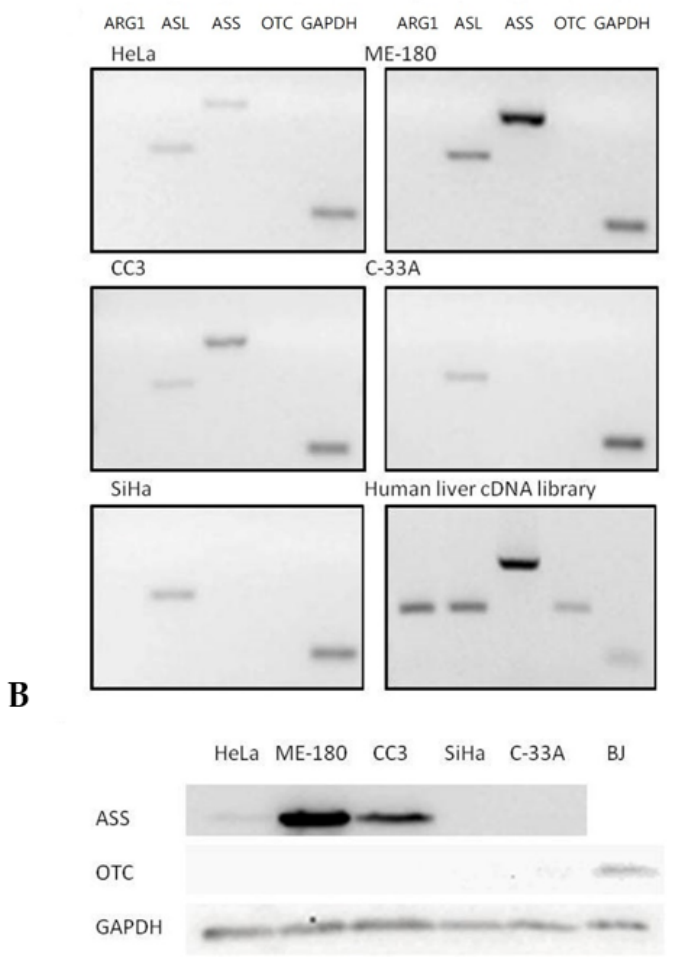
Figure 3. Expression profile of major urea cycle gene in human cervical cancer cells. ( A ) Transcriptional expression profiles in five human cervical cancer cell lines. The gene expression profiles of the cervical cancer cells and a positive control human liver cDNA library were determined using semi-quantitative RT-PCR and analyzed using agarose gel electrophoresis. ( B ) Protein expression of ASS and OTC was measured by Western blot analysis in five human cervical cancer cell lines. A positive control was performed using a normal human fibroblast cell line BJ. GAPDH served as internal control in all cell lines.